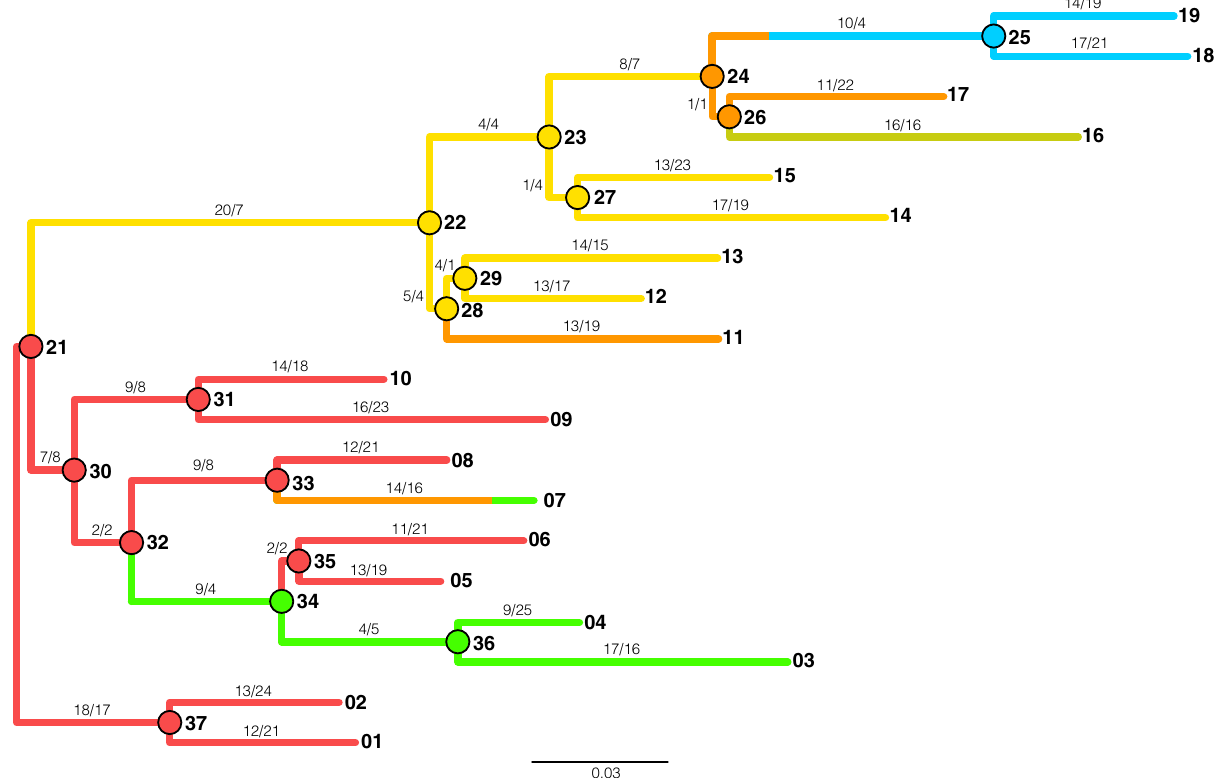
Figure 1 | Phylogram of the experimental phylogeny initiated from a single red FP gene. Scale bar represents amino acid replacements per site per unit evolutionary time. The colour of each branch reflects the colour-class phenotype (emission) of the node protein for internal branches or the leaf protein for tip branches (except for the branch connecting node 33 to leaf 7 that transitions through an orange intermediate). Nodes and tips are numbered for reference. Nonsynonymous and synonymous substitutions are shown along each branch, respectively. The experiment began near node 21 with a single red FP gene and proceeded by random-mutagenesis